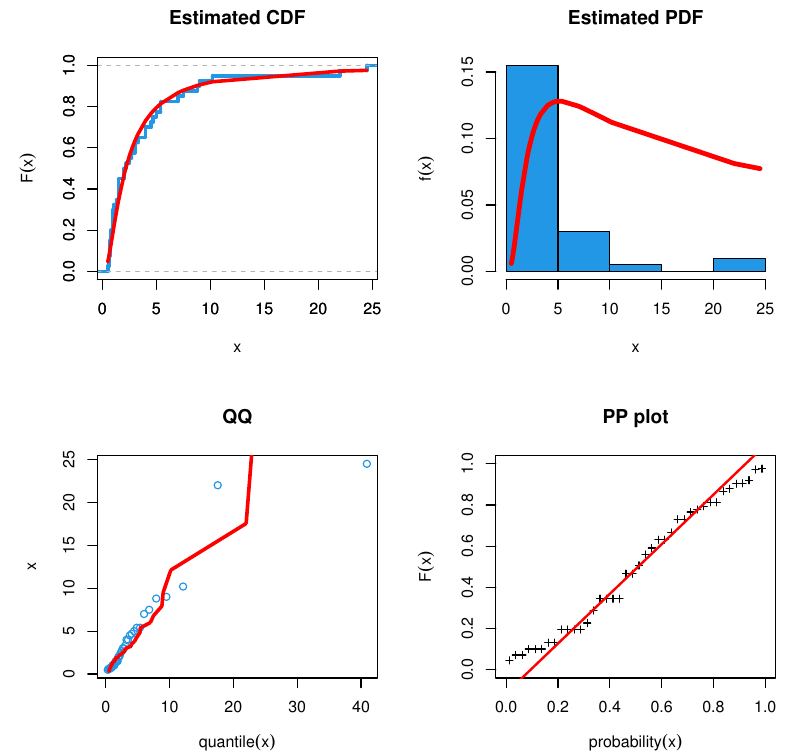
Figure 11. Estimated pdf, estimated cdf, PP and QQ plots for FB distribution for first dataset.